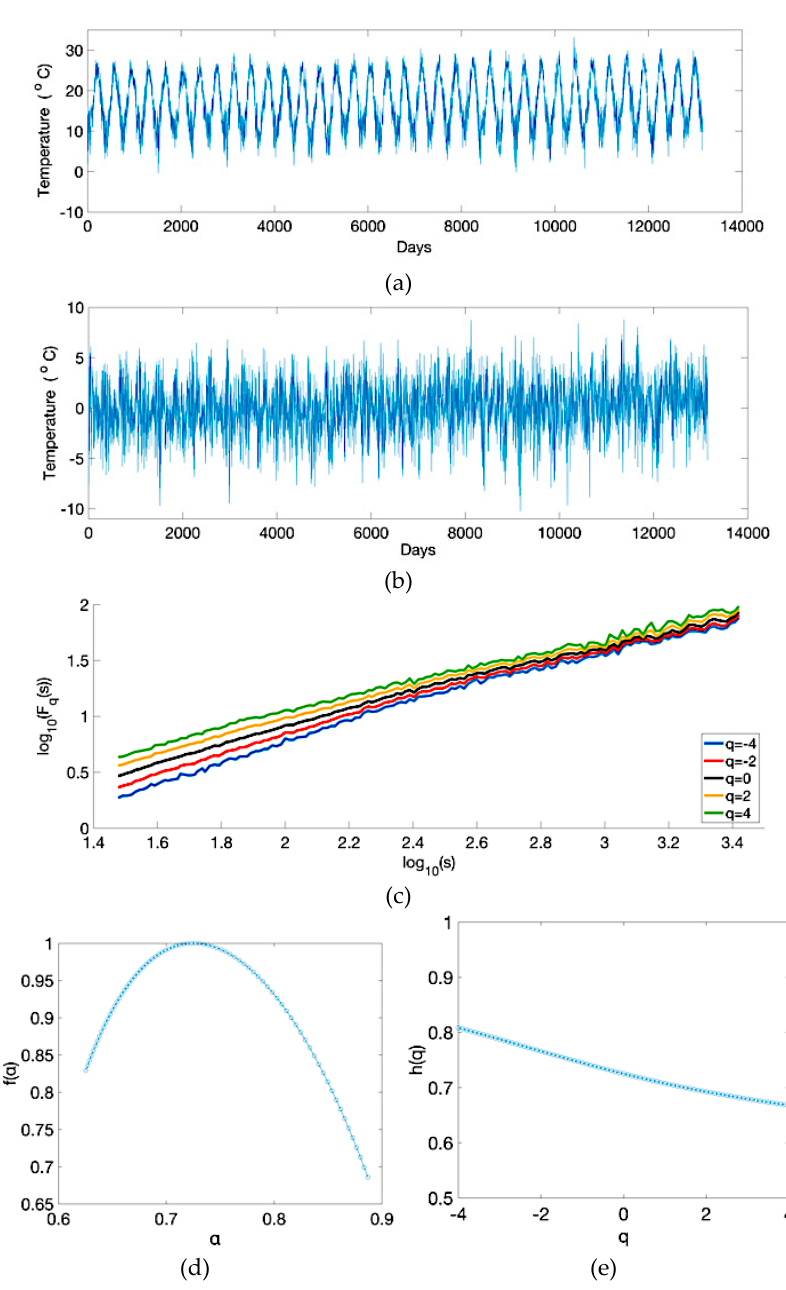
Figure 2. Original time series ( a ), deseasonalized time series ( b ), log-log plot of F q ( s ) versus s ( c ), multifractal spectrum f ( α ) versus α for the nearest grid point to Athens (38.25 ◦ N, 24.00 ◦ E) ( d ) and generalized Hurst exponent h(q) versus q plot ( e )